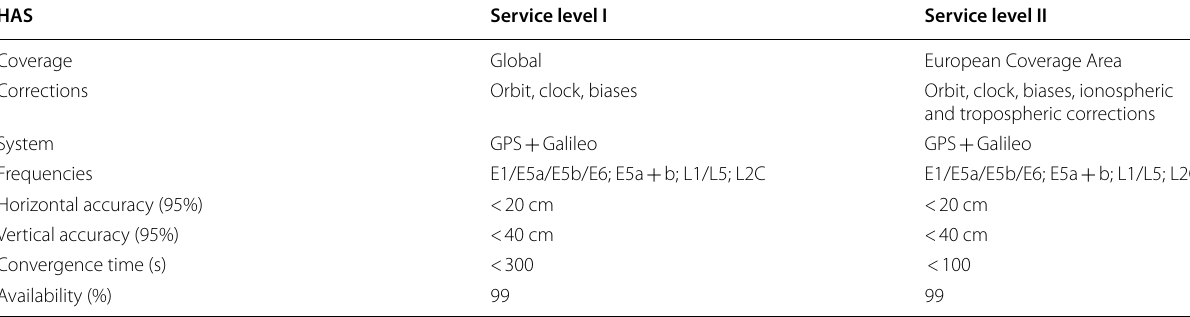
Table 4 Target performances of HAS service HAS